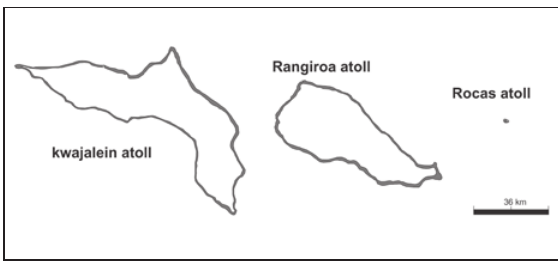
Figure 03 - Comparison between the dimensions of Kwajalein, Rangiroa and Rocas